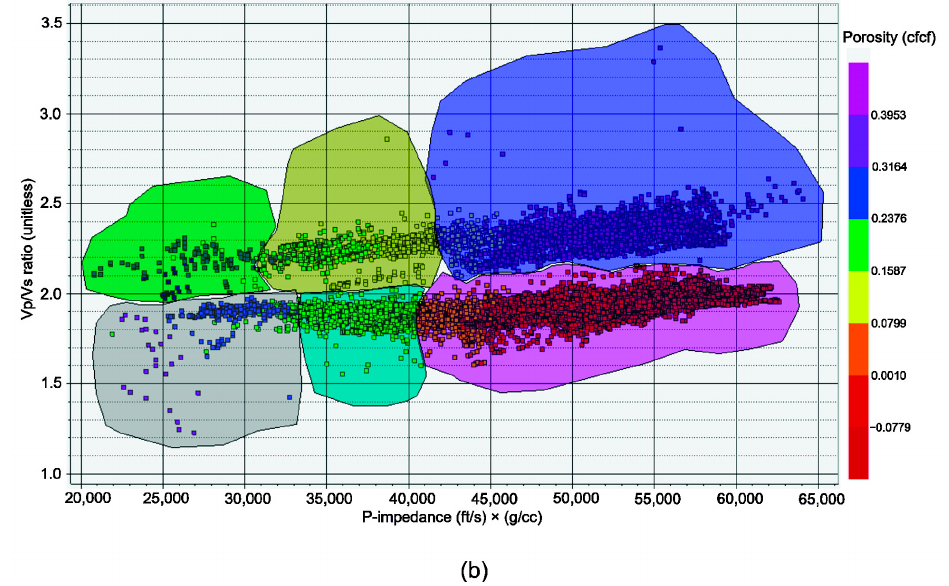
Figure 4. Cross plots of acoustic impedance versus Vp/Vs ratio, color coded with porosity showing ( a ) two linear trends suggesting two types of environmentally related deposits. Upper trend corresponds to high-Vp/Vs-ratio deposits; lower trend corresponds to low-Vp/Vs-ratio deposits. ( b ) Separation of trends into different zones for identification of different lithologies on the basis of porosity. Low-porosity zones correspond to carbonates, moderate-porosity zones correspond to sandstones, and high-porosity zones correspond to shales.